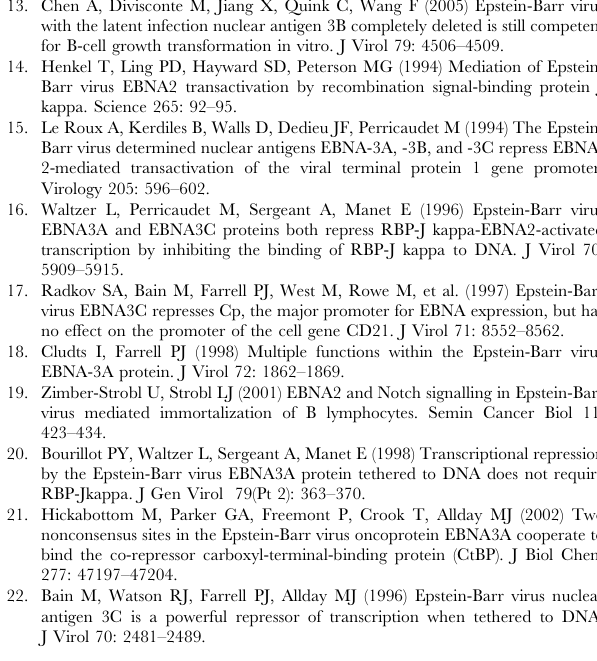
Table S7 Gene ontology cluster enrichment for 3BKO LCLs. Cluster enrichment scores for the 3BKO-LCL differentially expressed genes are indicated (see Table S2 for more details). Table S8 ANOVA statistics for genes differentially regulated by EBNA3A in both BL31 and LCLs. List of genes significantly altered by EBNA3A deletion (p , 0.001 and fold change . 2) in both 3AKO-BL31 cells and 3AmutB-LCLs (according to Hertle et al 2009). Table is separated into three sections (down-regulated in 3AKO cells, up-regulated, and up in 3AKO BL31 but down in 3AmutB LCLs (as per the numbers indicated in the venn diagram in Figure 10A). Three additional genes are included where 3AmutB statistics marginally failed to pass the significance or fold- change threshold, but when all 3Amut LCLs were included, they did pass these thresholds. Statistics for all probesets in the U133 microarray mapping to the gene (according to Ensembl genome annotation v56) are included. Those passing significance are indicated in bold. Green indicates up-regulated in the mutant, red indicates expressed at lower level. Genes are listed alphabetically by name in each section.